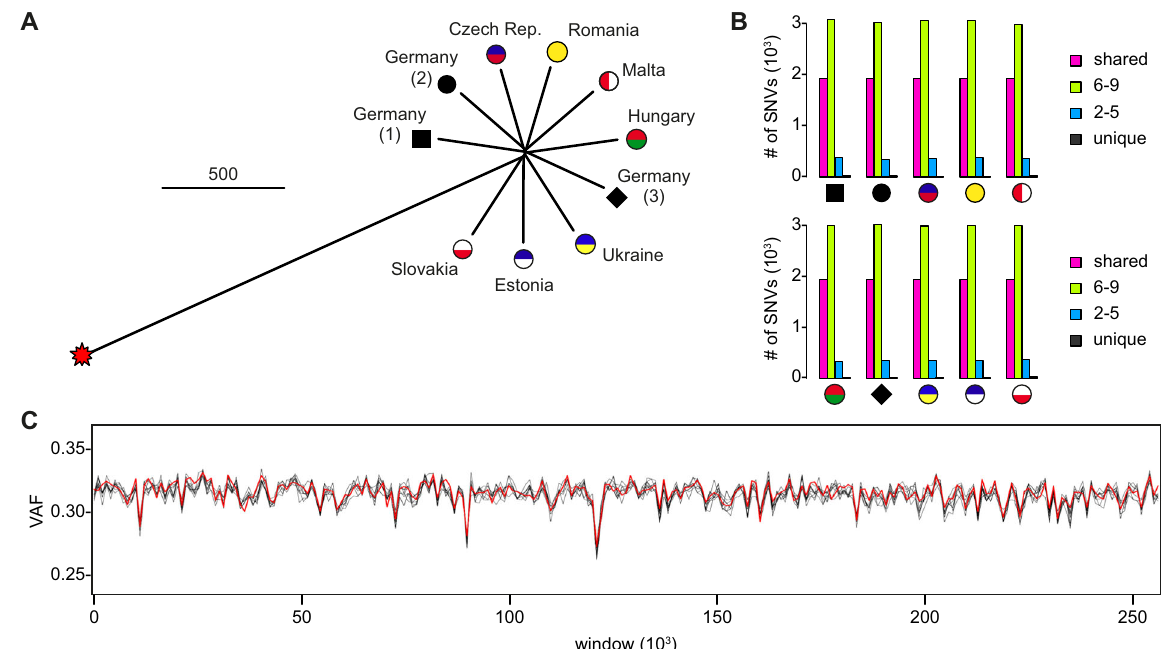
Fig. 2 Genetic relationships between representative specimens from ten different European populations, as determined by whole-genome sequencing (WGS). A Distance tree. Scale bar: 500 counts, representing 500 SNV from the set of common SNVs for all samples. The oldest known and likely foundational aquarium lineage of marbled cray fi sh is included as a reference (red star). B Bar plots illustrating the number of unique and shared SNVs. 6 – 9 and 2 – 5 indicate the number of SNVs that are shared by 6 to 9 and 2 – 5 animals, respectively. C Genome-wide analysis of variant allele frequency (VAF). Lines represent the average VAF per window of 10,000 heterozygous positions for each of the ten reference specimens. Variant allele frequencies are highly similar for all specimens and do not provide any evidence for loss of heterozygosity. The red line indicates the reference genome.